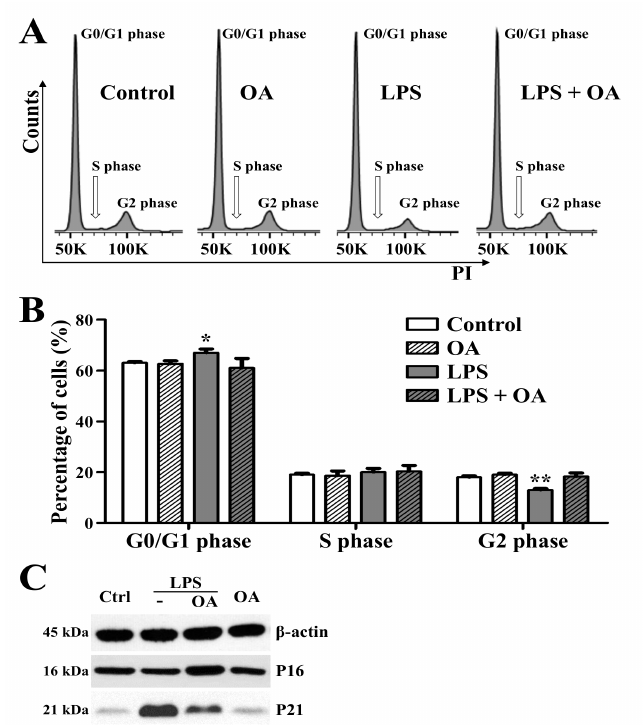
Figure 7. p21 but not p16 controls the alteration of cell cycle process in Raw264.7 cells under LPS or OA treatments. (A) Flow cytometry analysis revealed the increase of G0/G1 phase and the reduction of G2 phase. (B) Summary of A. (C) Western blot analysis revealed that the expression of p16 remained steady while the expression of p21 changed significantly. The molecular weight of each protein was indicated at the left side of the